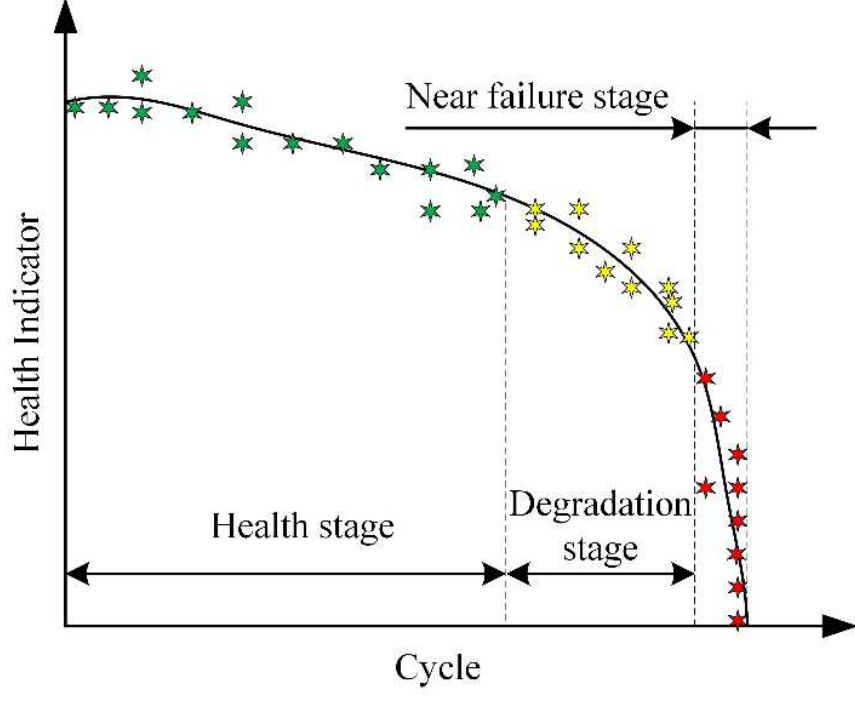
Figure 3. Degradation stages of an aero-engine.